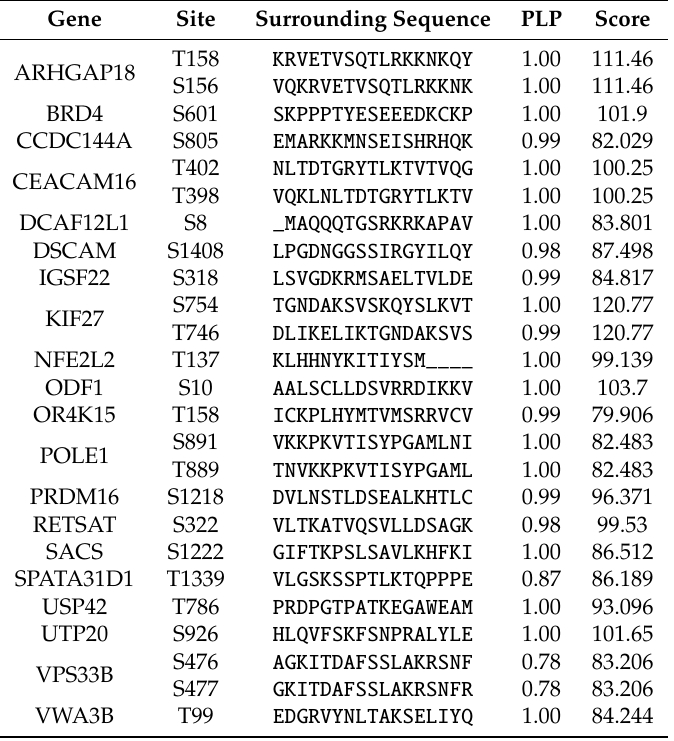
Table 1. The list of 20 putative PKN3 substrates with the highest identification score. Surrounding sequence of +/ − 8 amino acids around the identified phosphosite is shown. PLP—phosphosite localization